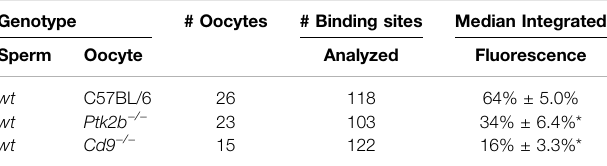
TABLE 1 | Effect of Ptk2b or Cd9 ablation on β -catenin recruitment to sperm binding sites. Genotype